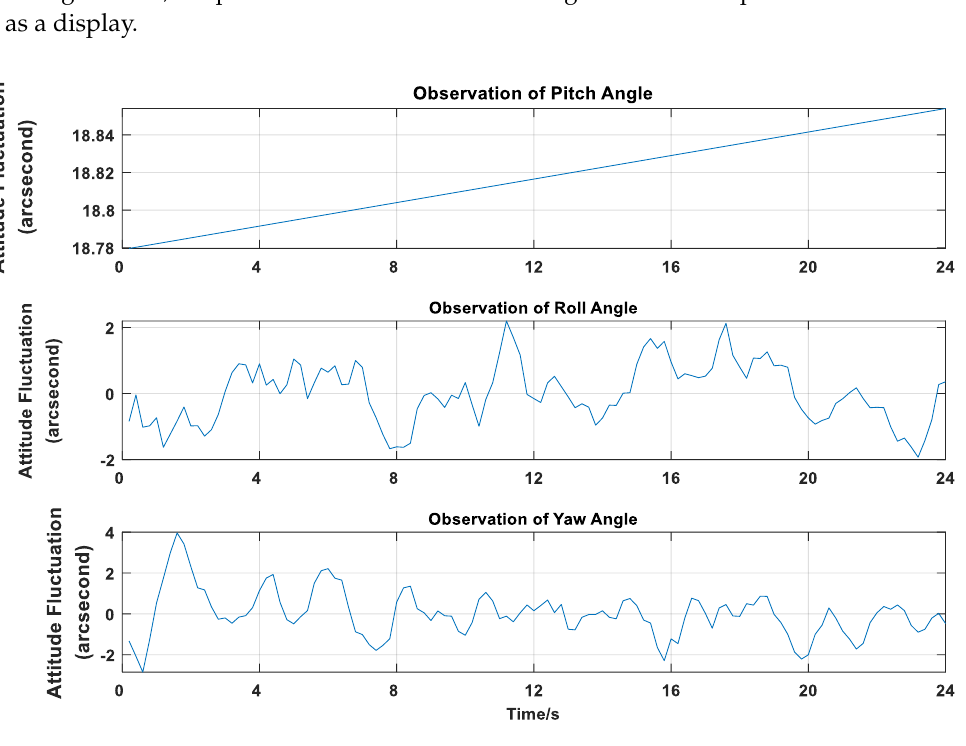
Figure 4. Imaging Attitude Observations of the Remote Sensing Camera.